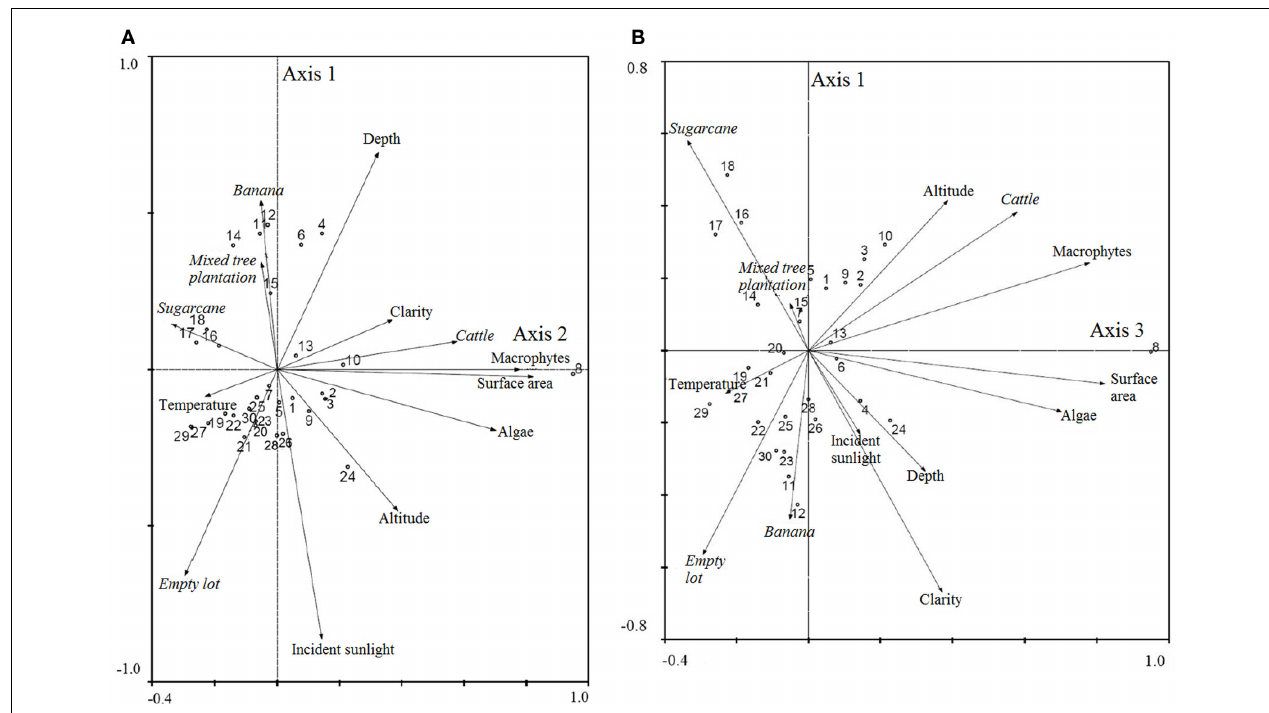
FIGURE 2 | Bi-plot results of principal components analysis of land uses and habitat characteristics for (A)Axes 1 and 2 and (B)Axes 1 and 3. Output from CANOCO (2002).